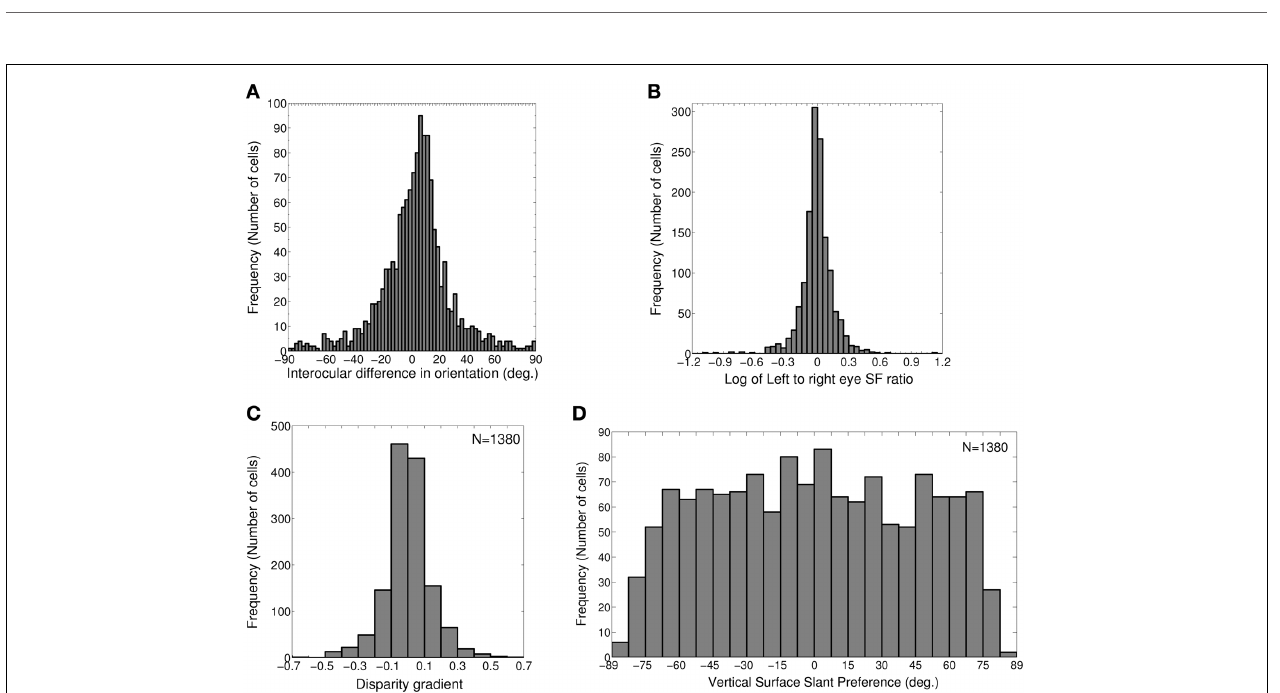
ratio > 1.2. (C) Histogram of disparity gradient of the cells in (B) . The disparity gradient lies in the range ± 0.95 ( S = 0 . 15). (D) Histogram of vertical surface slant preference for cells in (B)